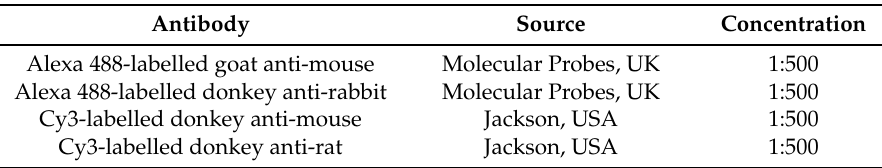
Table 2. Secondary antibodies used for